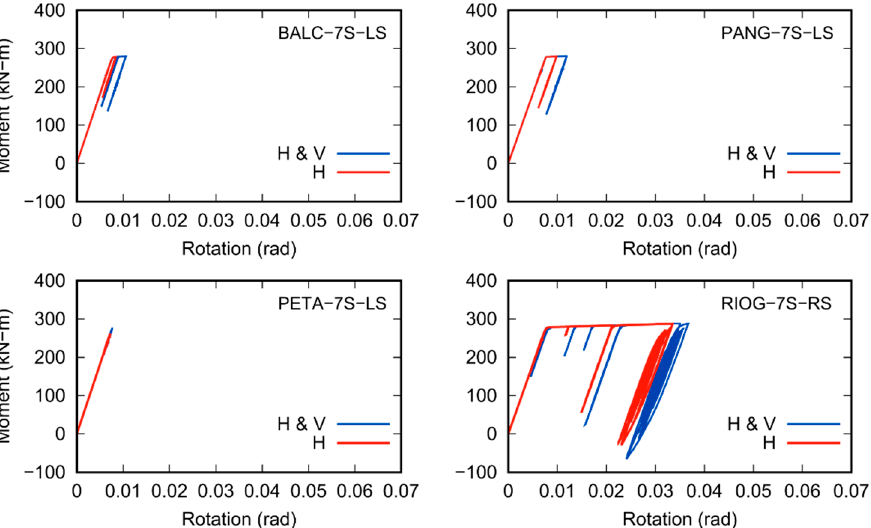
quakes; 8-story building (Part 2).